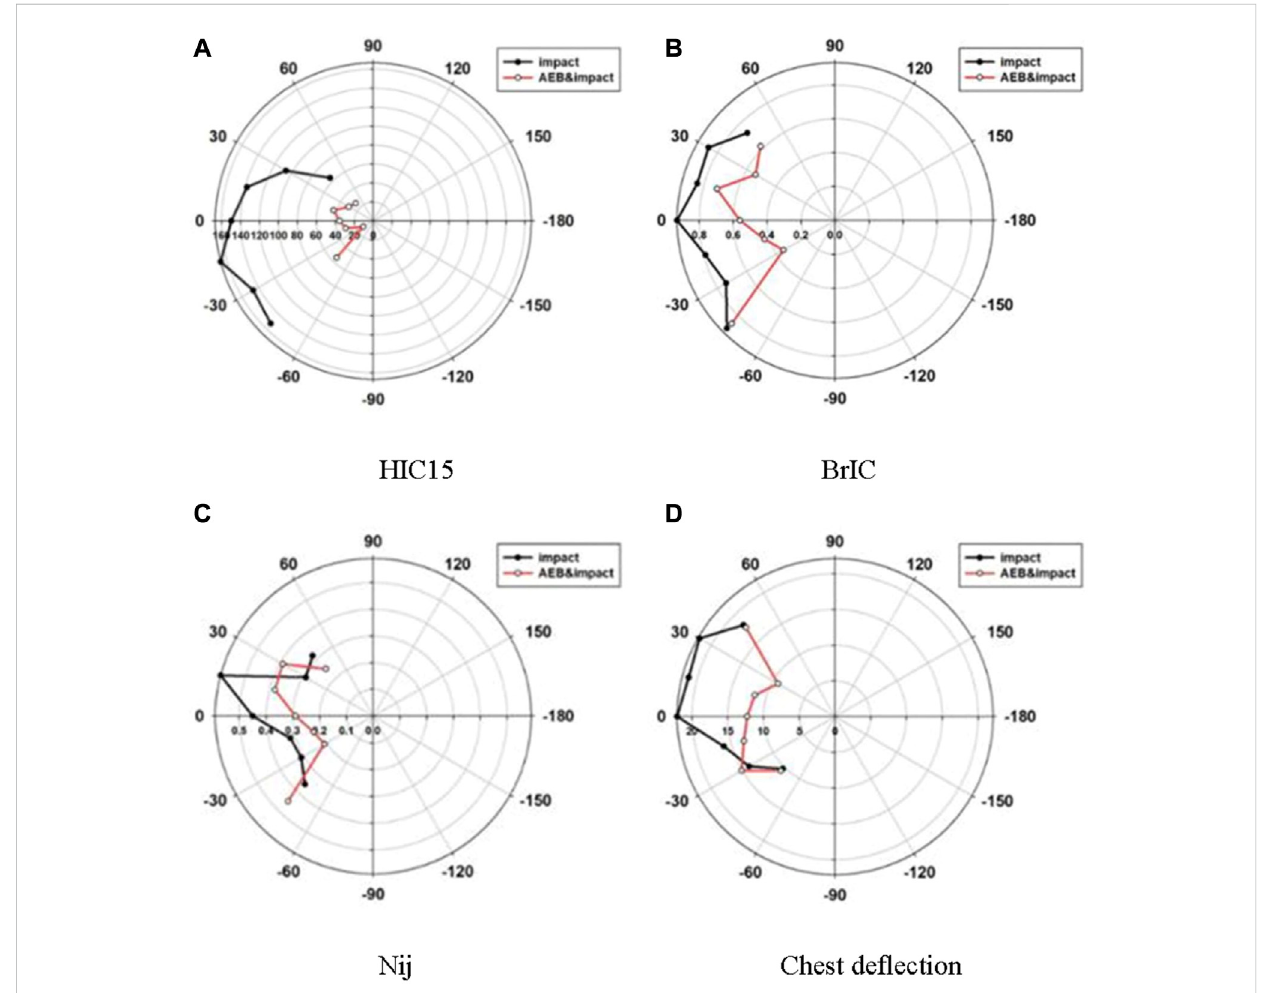
FIGURE 15 Comparison of injury number in impacts with and without AEB. (A) HIC15 (B) BrIC (C) Nij (D) Chest de fl